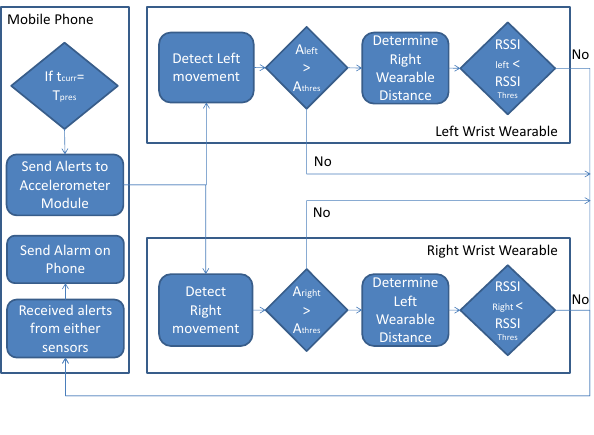
Figure 1. SmartMATES System